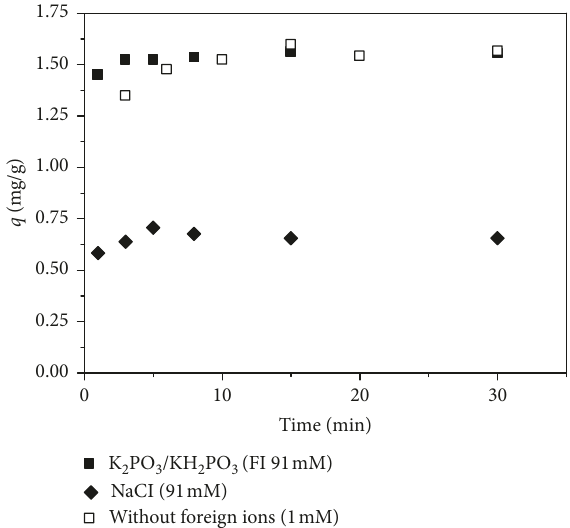
Figure 11: Effect of the controlled pH on cobalt adsorption using MCSG60A. Conditions: [Co 2+ ] dosage 12.5g/L, pH 6, particle size (cid:30)